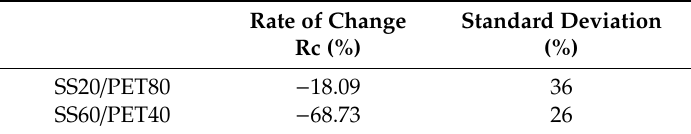
Table 5. Cracking mechanism influence on the electrical conductivity of the SS20 / PET80 and SS60 / PET40